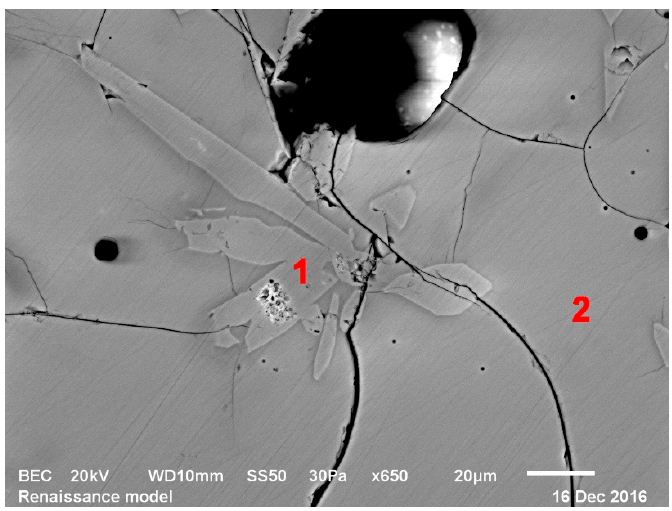
Figure 6. Wollastonite crystals in Renaissance model glass, 1000 °C, SEM; 1—wollastonite, 2—glass.